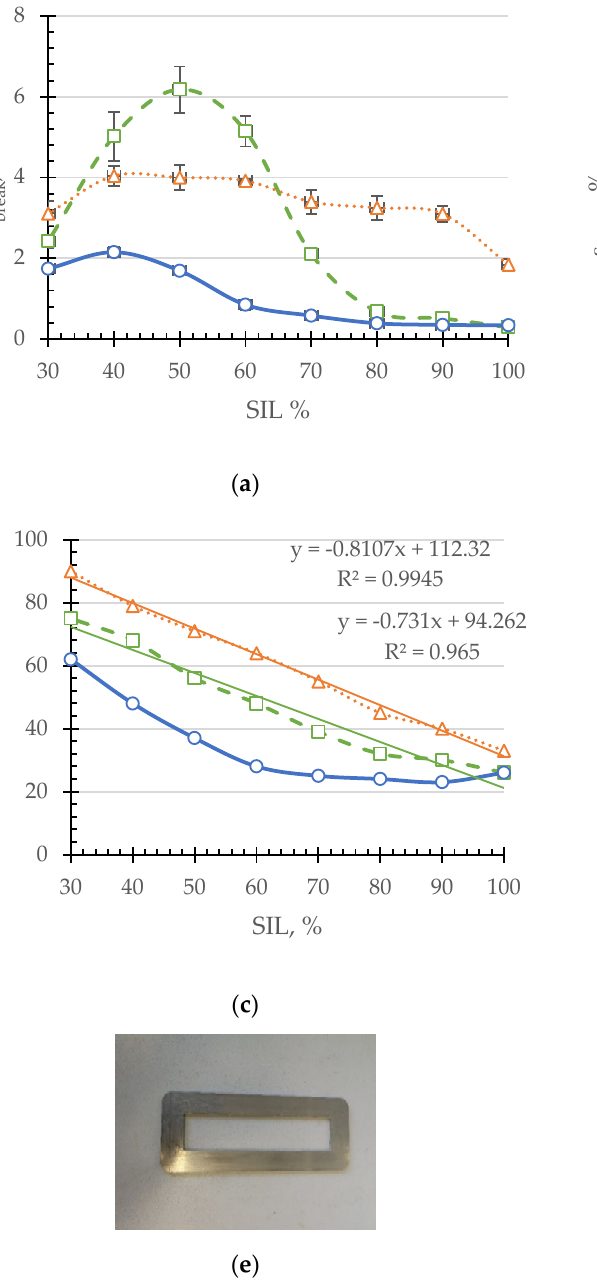
Figure 1. Tensile stress ( a ) and tensile strain ( b ) at break and Shore A hardness ( c ) of SIL/EP model systems ( ‐ ○ ‐ ), compatibilized model systems ( ‐□‐ ) and completed systems ( ‐∆‐ ) after 28 days of curing in standard conditions (T = 23 °C; RH = 50%), and the change of tensile stress (left axis, closed symbols) and tensile strain (right axis, open symbols) values during curing ( d ) of SIL50/EP50 compositions. The materials were formed into a metal frame ( e ) and cut out with a cutter ( f ) of a certain size, according to ISO 527 standard.